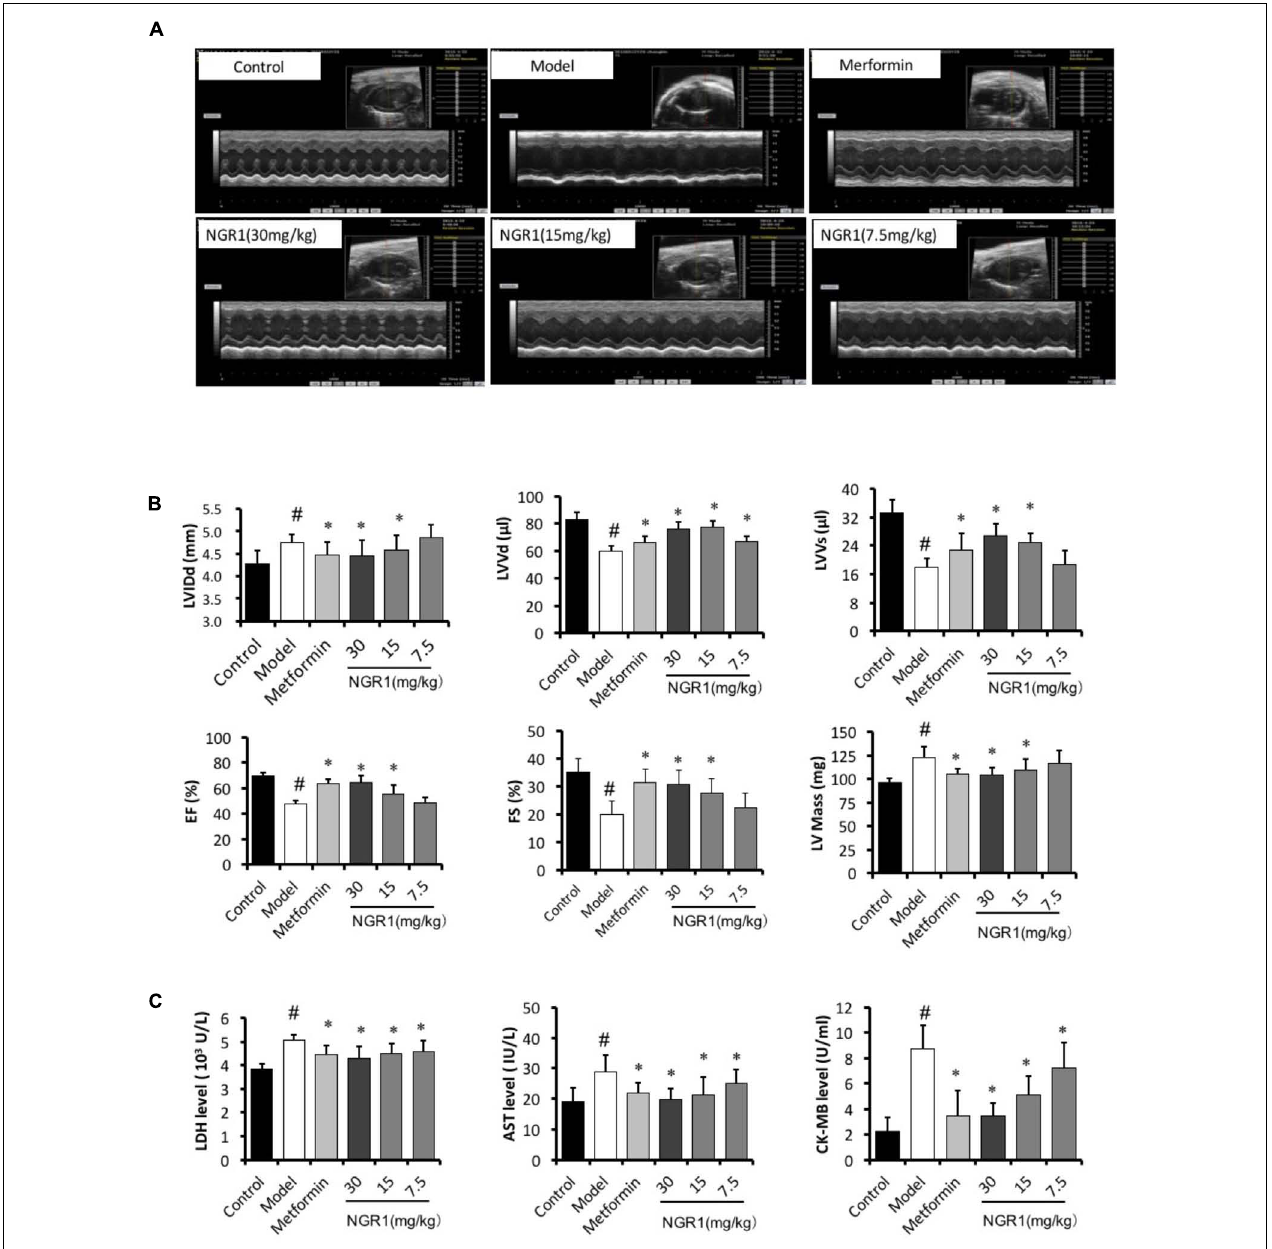
FIGURE 5 | NGR1 improves cardiac function of db/db mice. (A) Representative image of M-mode echocardiography. (B) Statistics of LVIDd, LVVd, LVVs, Ejection fraction, fractional shortening, and LV mass in different groups. (C) NGR1 decreased serum levels of LDH, AST, and CK-MB in db/db mice. The quantitative data are presented as the mean ± SD ( n = 8). # P < 0.05 vs. the Control group, ∗ P < 0.05 vs. the Model